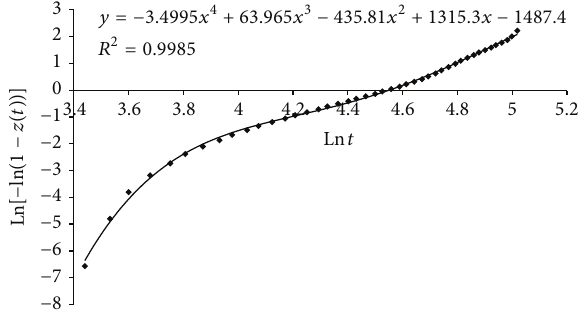
Figure5:Plotofln [− ln ( 1 −𝑧(𝑡))] againstln 𝑡 forInlayingonaPTFE layer 0.5 mm thick and nominally crystallized at 156 ∘ C.